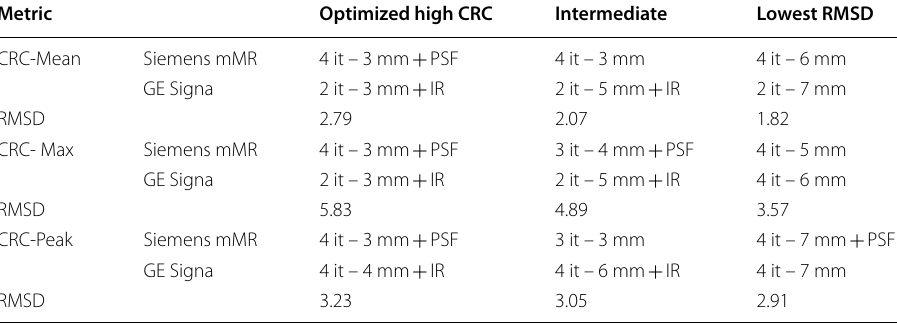
Table 2 Image reconstruction parameters leading to three optimization criteria for CRC and CRC for 30 min data acquisition. All Siemens mMR reconstructions were done with 21 max peak subsets, while all GE Signa reconstructions were done with 16 subsets and TOF (time of flight)